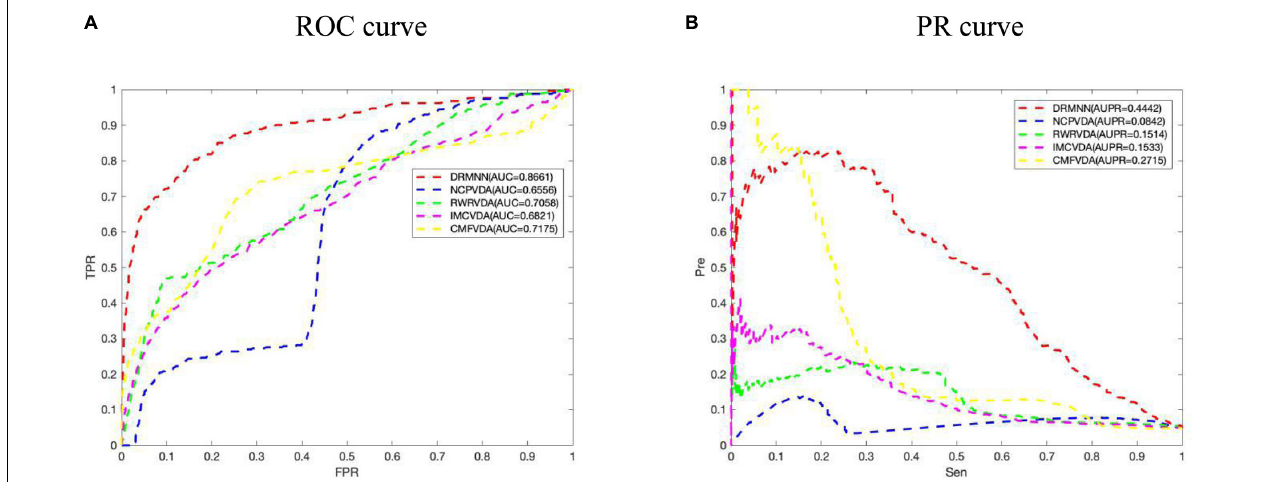
FIGURE 2 | Comparison of predictive performance of DRMNN, NCP, RWR, CMF, and IMC. (A) ROC curve and AUC value based on the global fivefold CV. (B) PR curve and AUPR values based on global fivefold CV.